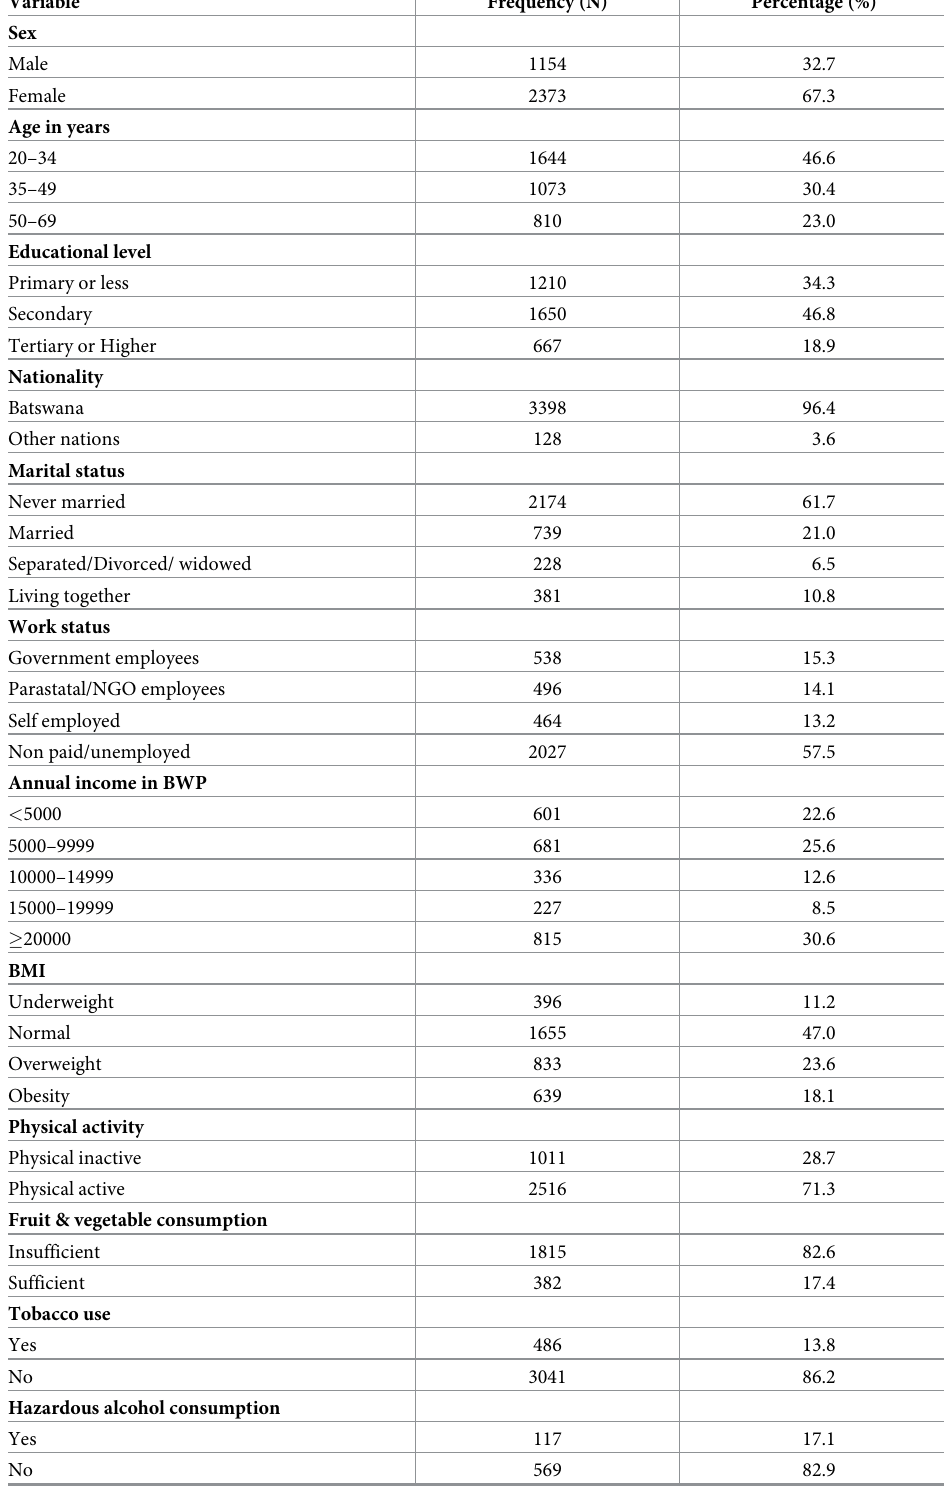
Table 1. Weighted socio economic and demographic characteristics of the study